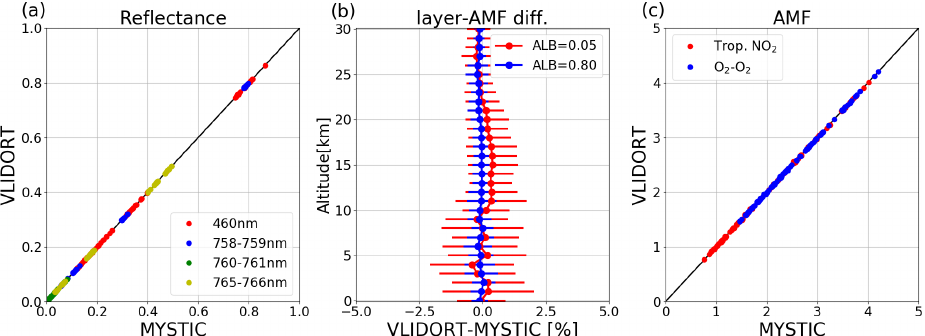
Figure 1. Comparison of radiative transfer models (MYSTIC and VLIDORT). (a) TOA reflectance simulated at 460, 758–759, 760–761, and 765–766nm. (b) Relative difference of layer-AMFs. Red (albedo = 0 . 05) and blue (albedo = 0 . 8) circles with error bars (standard error) are calculated for a variety of geometries. Relative difference between a and b is calculated using (a − b)/b · 100% herein. (c) Comparison of AMF calculated with a highly polluted tropospheric NO 2 profile (red) and an O 2 –O 2 profile